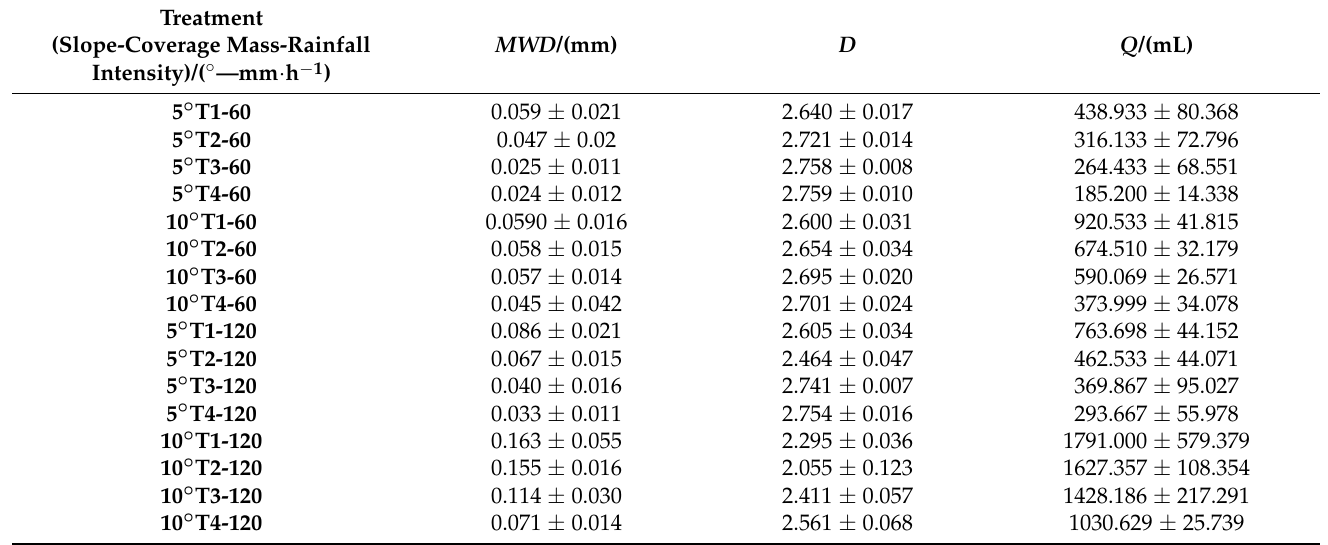
Table 3. Overland runoff, erosion, and eroded sediment characteristic parameters under different treatments. Treatment (Slope-Coverage